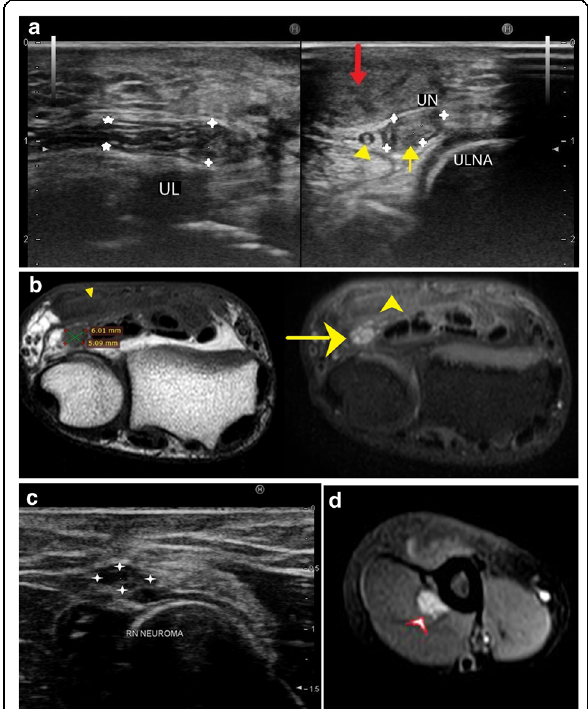
Fig. 12 a In a case with glass cut injury at the wrist, a hypoechoic ulnar nerve (between arrowheads) is noted with formation of neuroma in continuity (yellow arrow) characterised by thickened, hypoechoic focal area with loss of fascicular architecture. Also noted is soft tissue swelling (red arrow). Yellow arrowhead marks the ulnar artery. b T1- and PDFS-weighted images show the ulnar nerve neuroma which is hypointense on T1 and hyperintense on PDFS (between callipers and yellow arrow respectively) with associated soft tissue oedema (arrowhead). c Focal thickening suggestive of radial nerve neuroma (between cross marks) is seen distal to the spiral groove in a case with monkey bite at the arm. The nerve is seen lying between the brachialis and brachioradialis. d Axial PD fat- saturated sequence of the same patient demonstrates a well-defined ovoid hyperintense lesion (black arrowhead) in continuity with the radial nerve. As the lesion was noted distal to the spiral groove, after supply to the triceps, there is no signal intensity change in the triceps muscle signifying normal innervation to the